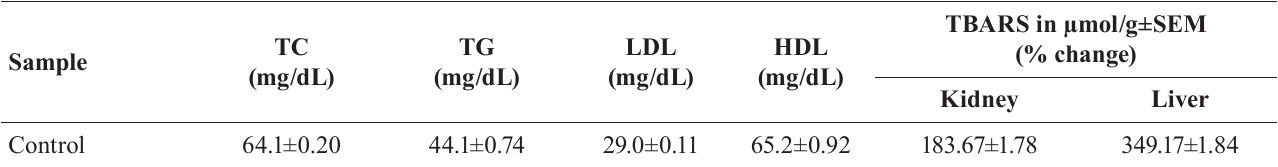
TABLE IV – The serum glucose concentrations, total cholesterol (TC), triglycerides (TG), High density lipoprotein (HDL) and low density lipoprotein (LDL) cholesterol levels and TBARS contents in diabetic rats due to the effect of ethyl acetate extract of C. baltica